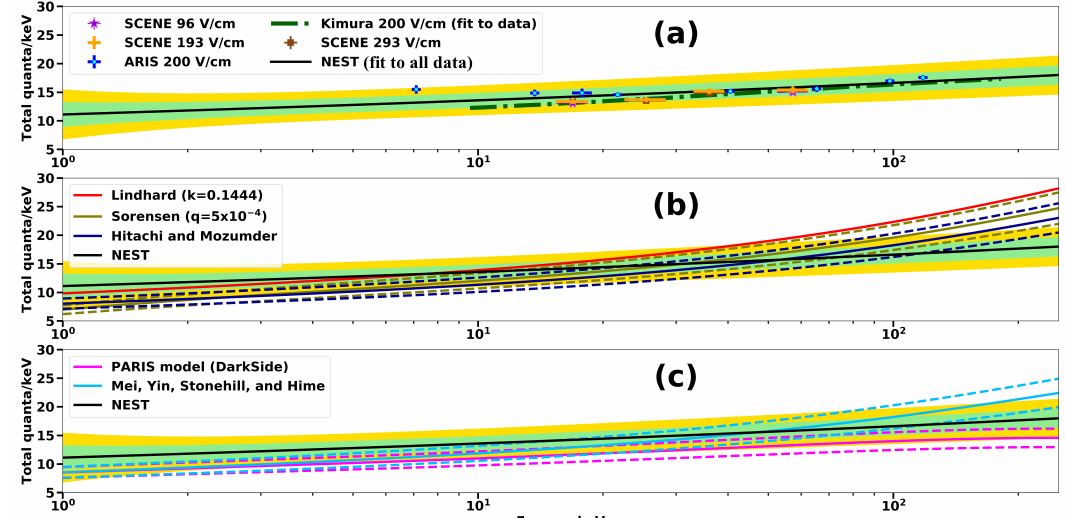
Figure 10. ( a ) The (E-field-independent) total number of quanta N q per keV for NR in liquid argon: L y + Q y , or ( N ph + N e − ) / E . The best-fit power law, used in the current NEST NR model for LAr, is ( 11.10 ± 1.10 ) E 0.087 ± 0.025 , surprisingly similar to LXe, with 1 σ /2 σ error bands in green/yellow. Kimura data [167] are given as a fit to the data in the original paper; SCENE and ARIS points are taken from [175,200]. ( b ) A review of models, collected from [132,143,201], covering Lindhard/Lindhard-like approaches. Solid lines assume 45 photons/keV for the (0 V/cm) L y of ER in LAr, with upper and lower dashes covering 50 and 40, respectively, to span the uncertainty in light, before addition with Q y . ( c ) As in ( a , b ), NEST is repeated here with two additional model comparisons, from PARIS (used by DS [202]) and